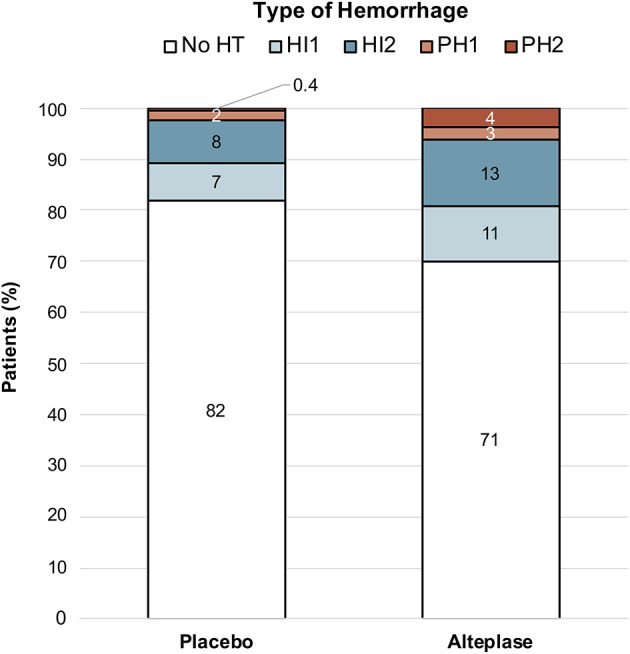
Distribution of Hemorrhages in relation to the treatment group. Distribution of Hemorrhage in relation to the treatment groups shows that any hemorrhage was more frequent in patients treated with alteplase. While HI occurred in both treatment groups, PH was mainly seen in patients treated with alteplase. ICH, intracerebral hemorrhage; HI1, hemorrhagic infarction type 1; HI2, hemorrhagic infarction type 2; PH1, parenchymal hemorrhage type 1; PH2, parenchymal hemorrhage type 2.